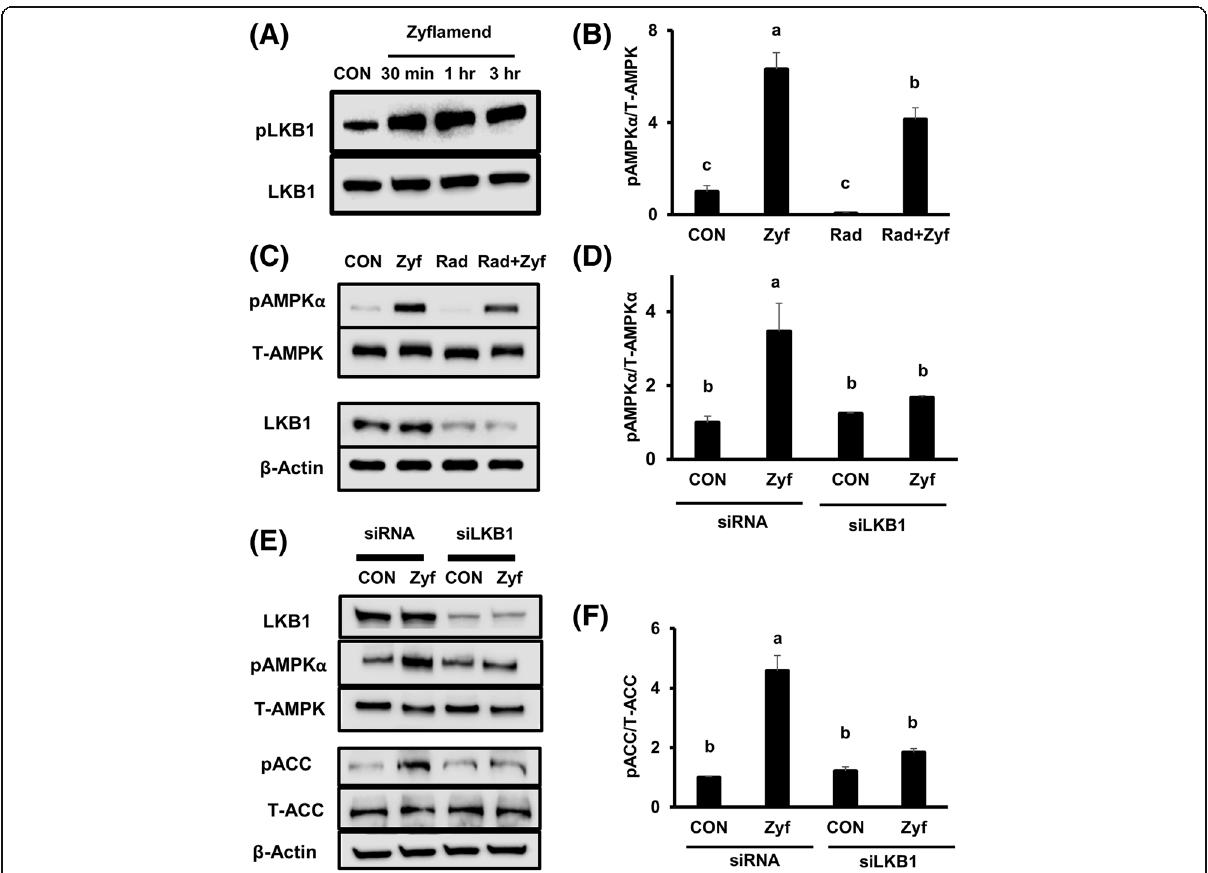
Fig. 5 The effects of Zyflamend on phosphorylation of LKB1 (at Ser428) and AMPK α (at Thr172) following inhibition with radicicol and knockdown of LKB1 in CWR22Rv1 cells. A Western blot of pLKB1± Zyflamend (200 μ g/mL, 30 min – 3 h). B , C Western blot of pAMPK α following treatment with radicicol (5 μ M, 24 h) ± Zyflamend (200 μ g/mL, 30 min). D - F Western blot of pAMPK α and pACC (at Ser79) following knockdown of LKB1 ± Zyflamend (200 μ g/mL, 30 min). Data are presented as mean ± SEM, n = 3. Bars with different letters are statistically different at p <